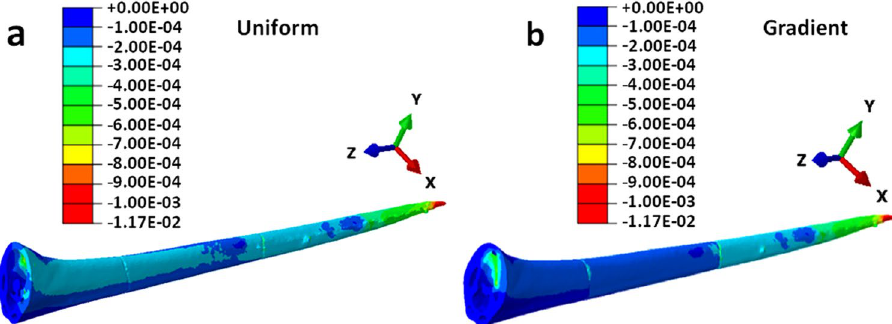
Figure 9. The compressive strain (E33) distribution pattern of the honeybee stinger; ( a ) stinger with uniform mechanical properties, and ( b ) stinger with gradient mechanical properties. For uniform stinger, relatively higher compressive strain spreads all over the stinger, whereas for gradient stinger it does not, and this justifies more mechanical stability of gradient